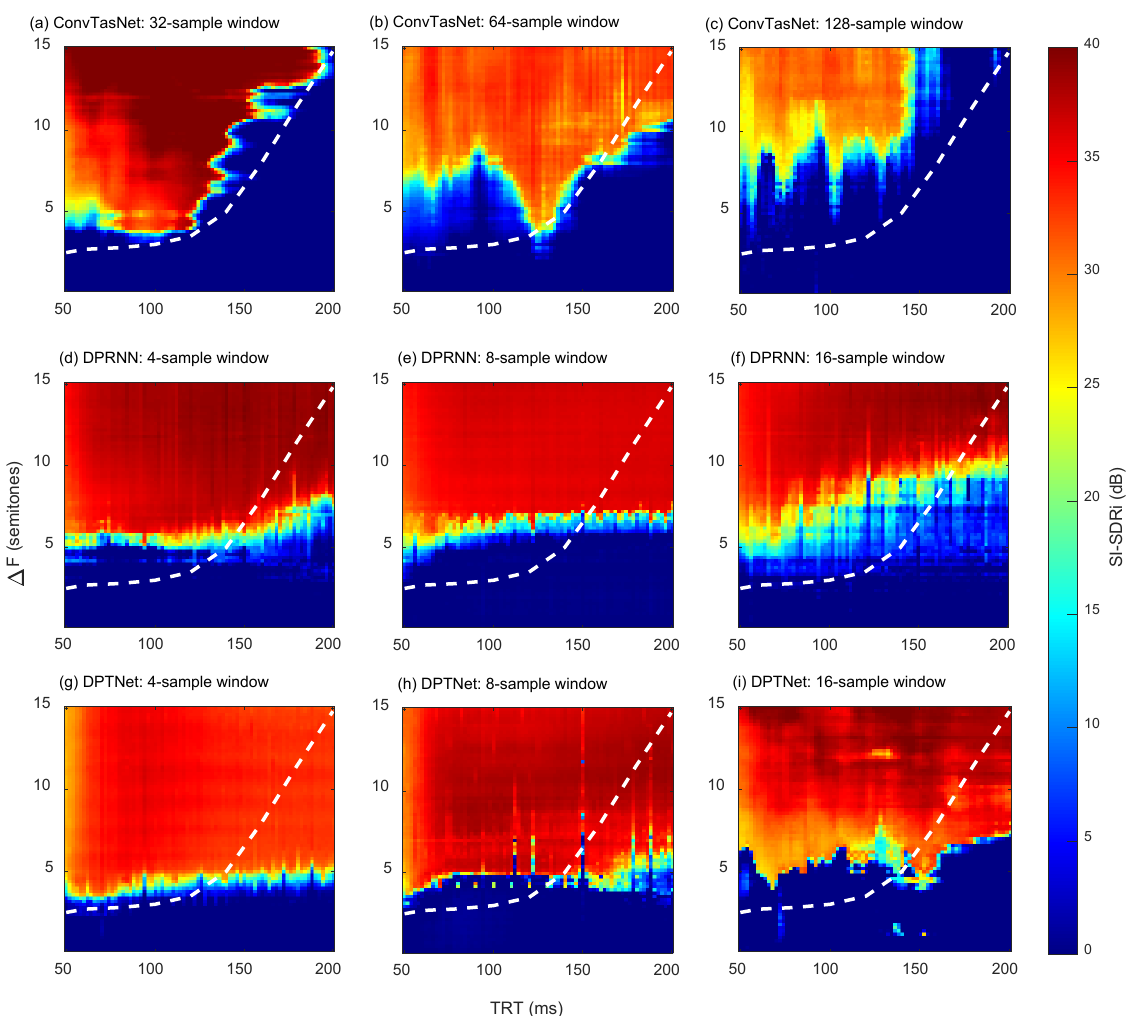
Figure 6. SI-SDRi (dB) as a function of TRT (ms) and ΔF (semitones), where ( a – i ) represent results of three well-trained networks (ConvTasNet, DPRNN, and DPTNet) with three different parameters, respectively. The dashed white curve indicates the temporal coherence boundary in the human auditory system.